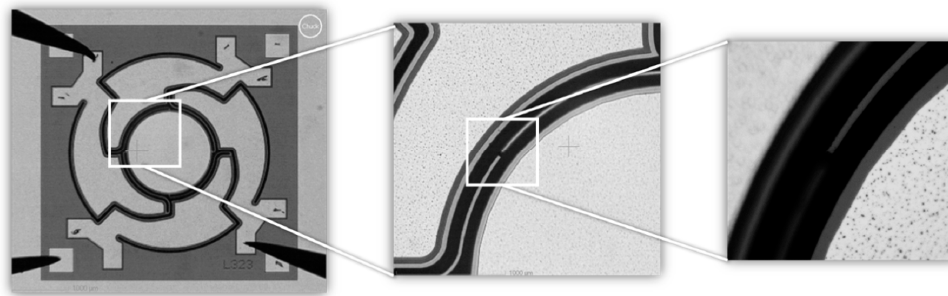
Figure 26. Microscope image of a micromirror of Design 2. After sweeping the frequency resonance curve at 50 V, one of the 7.5 µm springs was broken after an undefined oscillation occurred.